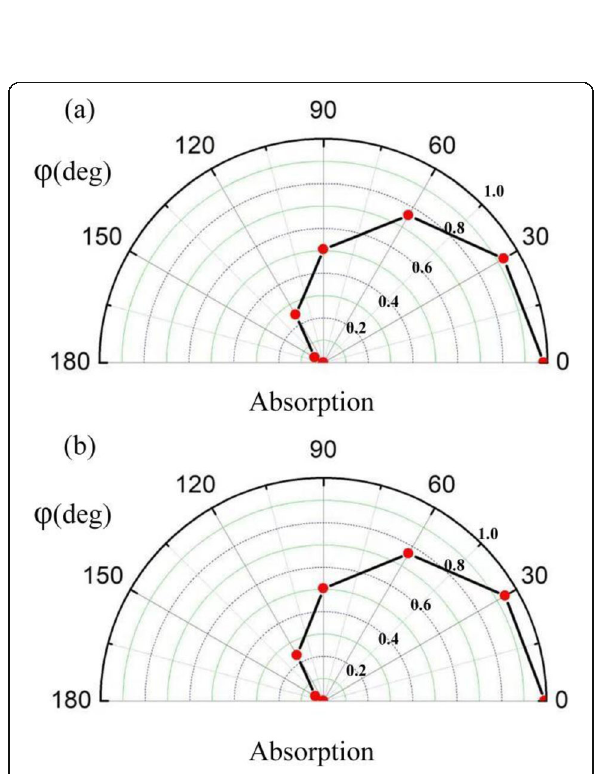
Fig. 5 The absorption of proposed CPA with different phase difference at the peaks of a λ 1 = 9611 nm and b λ 2 = 9924 nm,